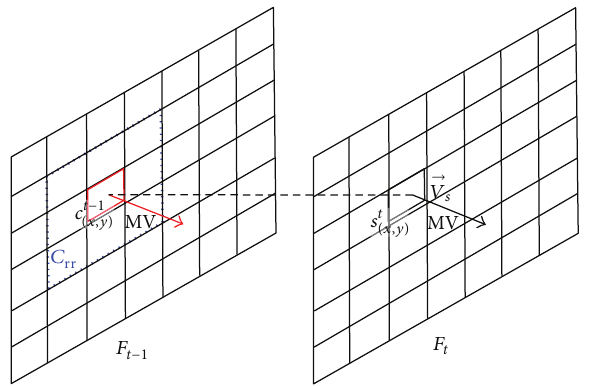
Figure 6: Schematic diagram of position relationship.